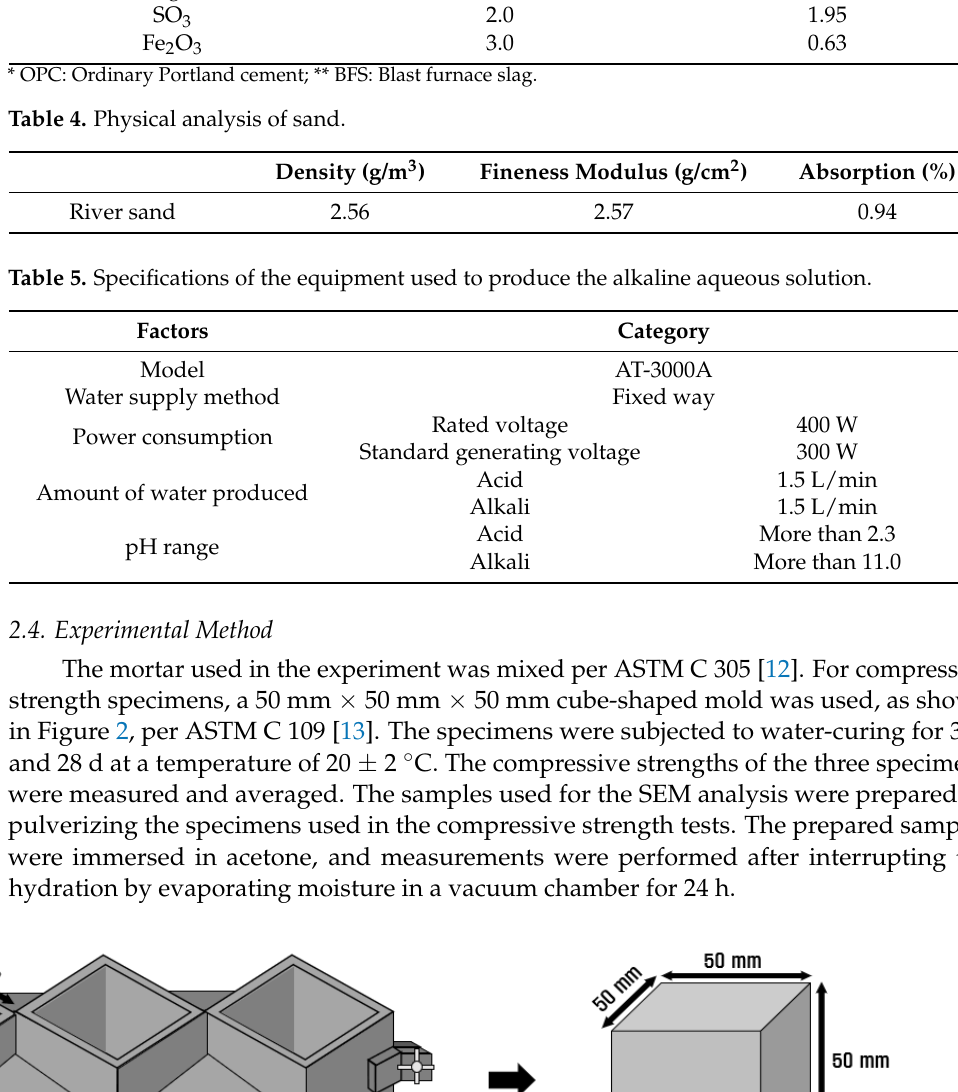
Figure 3. Accelerated carbonation test specimen mold. 3. Results and Discussion 3.1. Compressive Strength The compressive strengths at 3, 7, and 28 d of age are shown in Figure 4. The com- pressive strengths after 3, 7, and 28 d of age were 17.88, 23.62, and 28.24 MPa for samples with only OPC; 7.47, 11.12, and 23.99 MPa for BFS50 specimens; 12.33, 16.55, and 27.06 MPa for ABFS25 specimens; and 8.66, 12.29, and 25.48 MPa for ABFS50 specimens, respec- tively. Figure 4. Mortar compressive strength test results (MPa). (1) OPC: Ordinary Portland cement; OPC:BFS = 100:0 (normal water); (2) BFS25: Blast furnace slag; OPC:BFS = 75:25 (normal water); (3)